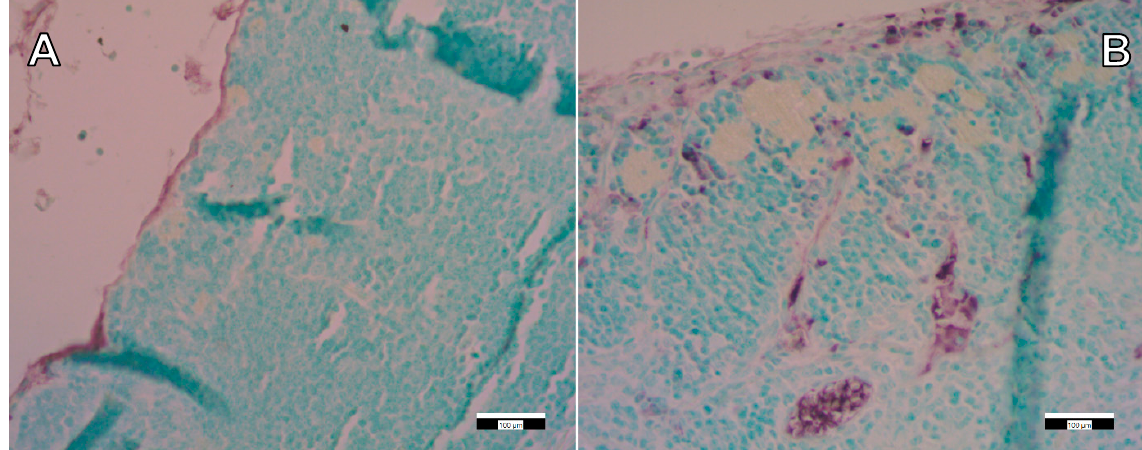
Figure 8. Immunohistochemical staining (CD163) of control ( A ) and “high dose” FSGM-treated ( B ) thymus tissue. Scale bars: 100 µm.